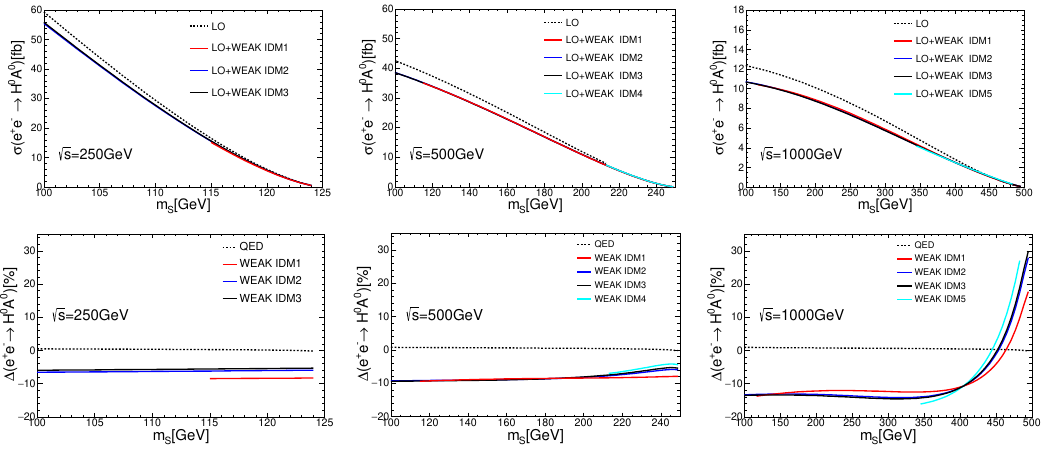
Figure 14 . In Scenario I, total cross sections and relative corrections as a function of the Higgs √ mass for e + e − → H 0 A 0 with three CM energies s = 250 GeV, 500 GeV and 1000 GeV, where the corresponding values of µ 2 are given in table 2